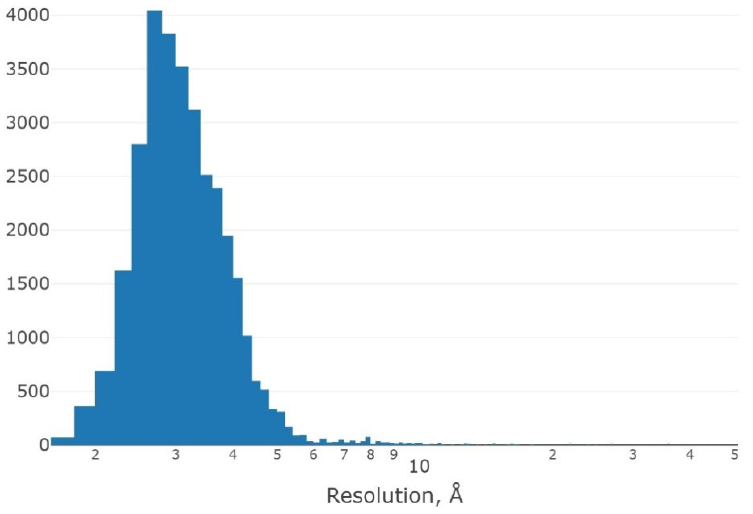
Figure 3. Histogram of the distribution of the number of protein structures containing motifs of the dataset, depending on the resolution quality (logarithmic